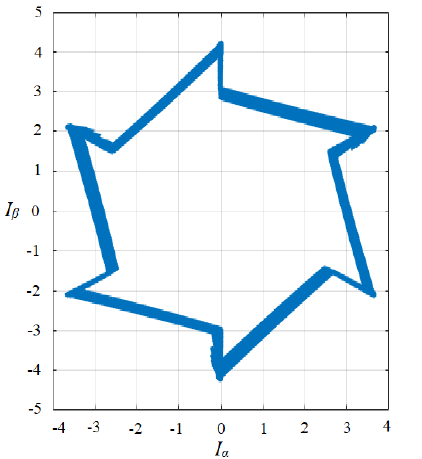
Figure 3. The equivalent current vector hodograph of the EDP motor’s simulation